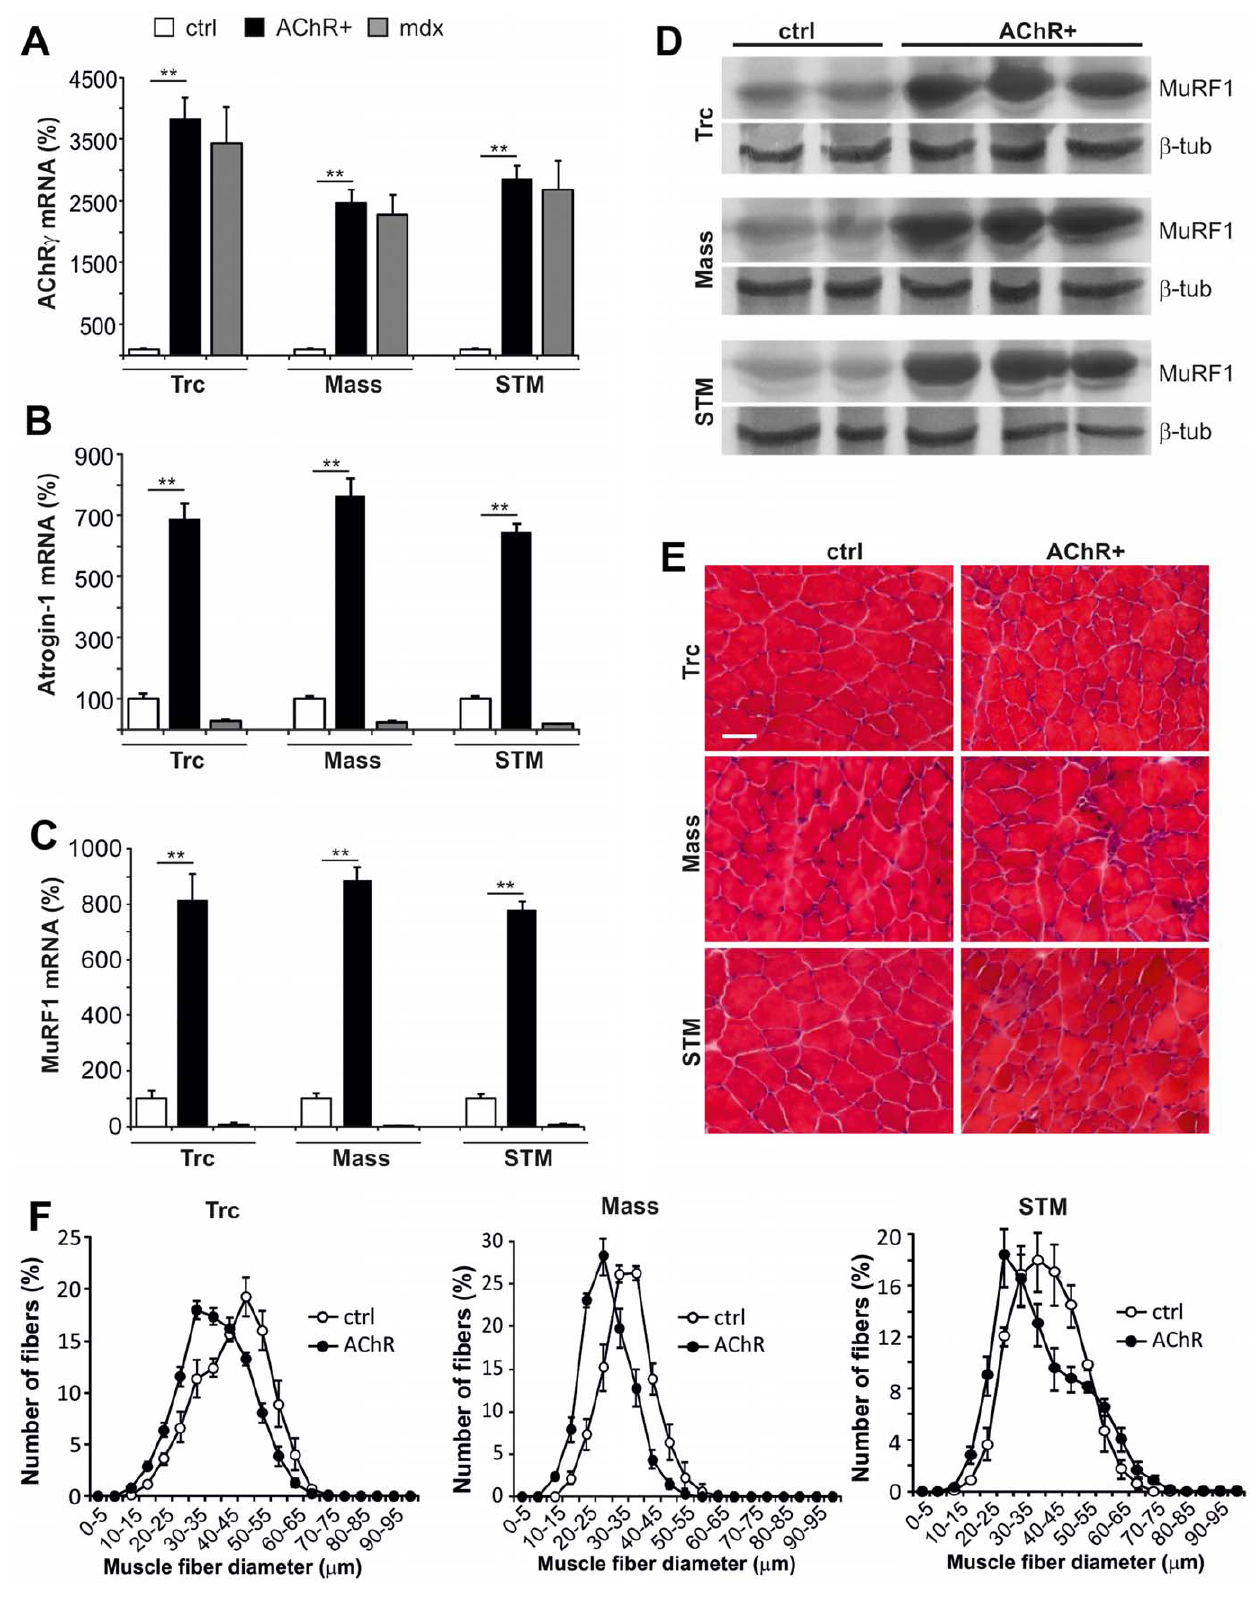
Figure 5. Denervation and atrophy in triceps (Trc), masseter (Mass) and sternomastoid (STM) muscles of EAMG mice. (A) mRNA levels of AChR c subunit, a marker for blocked neuromuscular transmission and denervation, were up-regulated 25–40 times (p , 0.005 for all muscles) in muscles of AChR + EAMG mice (n=6) when compared to controls (ctrl; n=3). (B) mRNA levels of the atrophy-related gene atrogin-1 were 6.5–